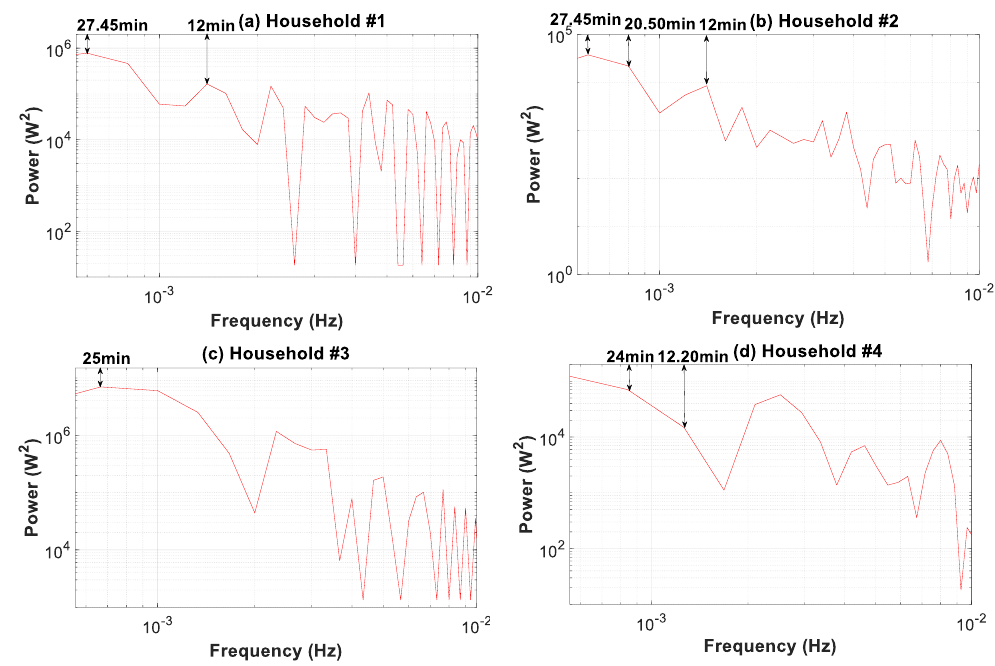
Figure 15. Partial autocorrelation function of the consumption load profile in households #1 to #4 for four data granularities.